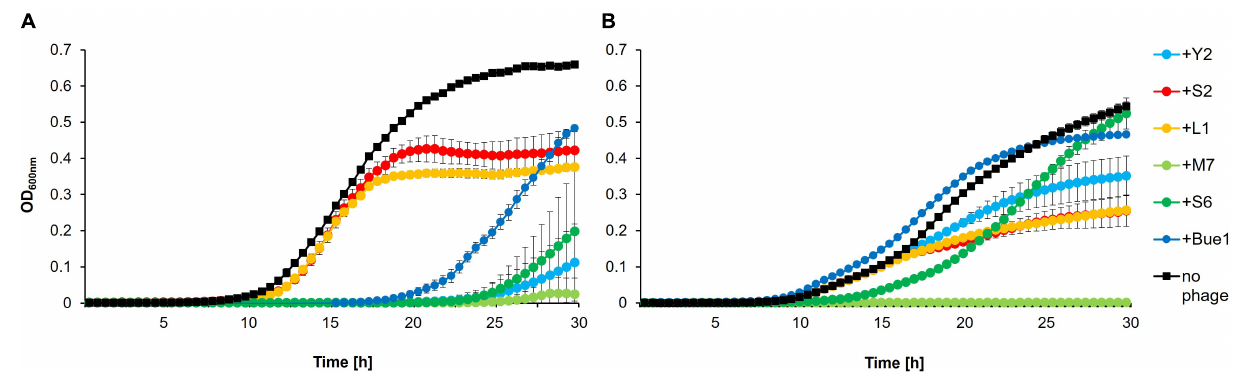
FIGURE 1 | In vitro infection assay. Growth of (A) Erwinia amylovora CFBP 1430 or (B) 1430 Y 2 R infected with phages. Bacterial concentrations of 10 5 CFU/ml were infected with 10 8 PFU/ml phage and incubated over 30 h. Optical density (OD 600 nm ) was measured regularly at 30-min intervals. Error bars indicate standard deviations. The experiment was performed with three biological and three technical replicates.